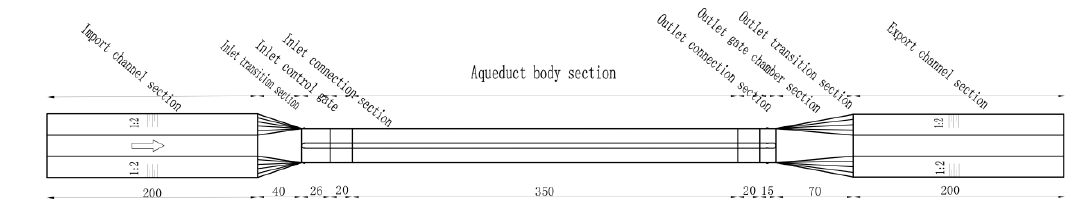
Figure 1. Aqueduct floor plan.